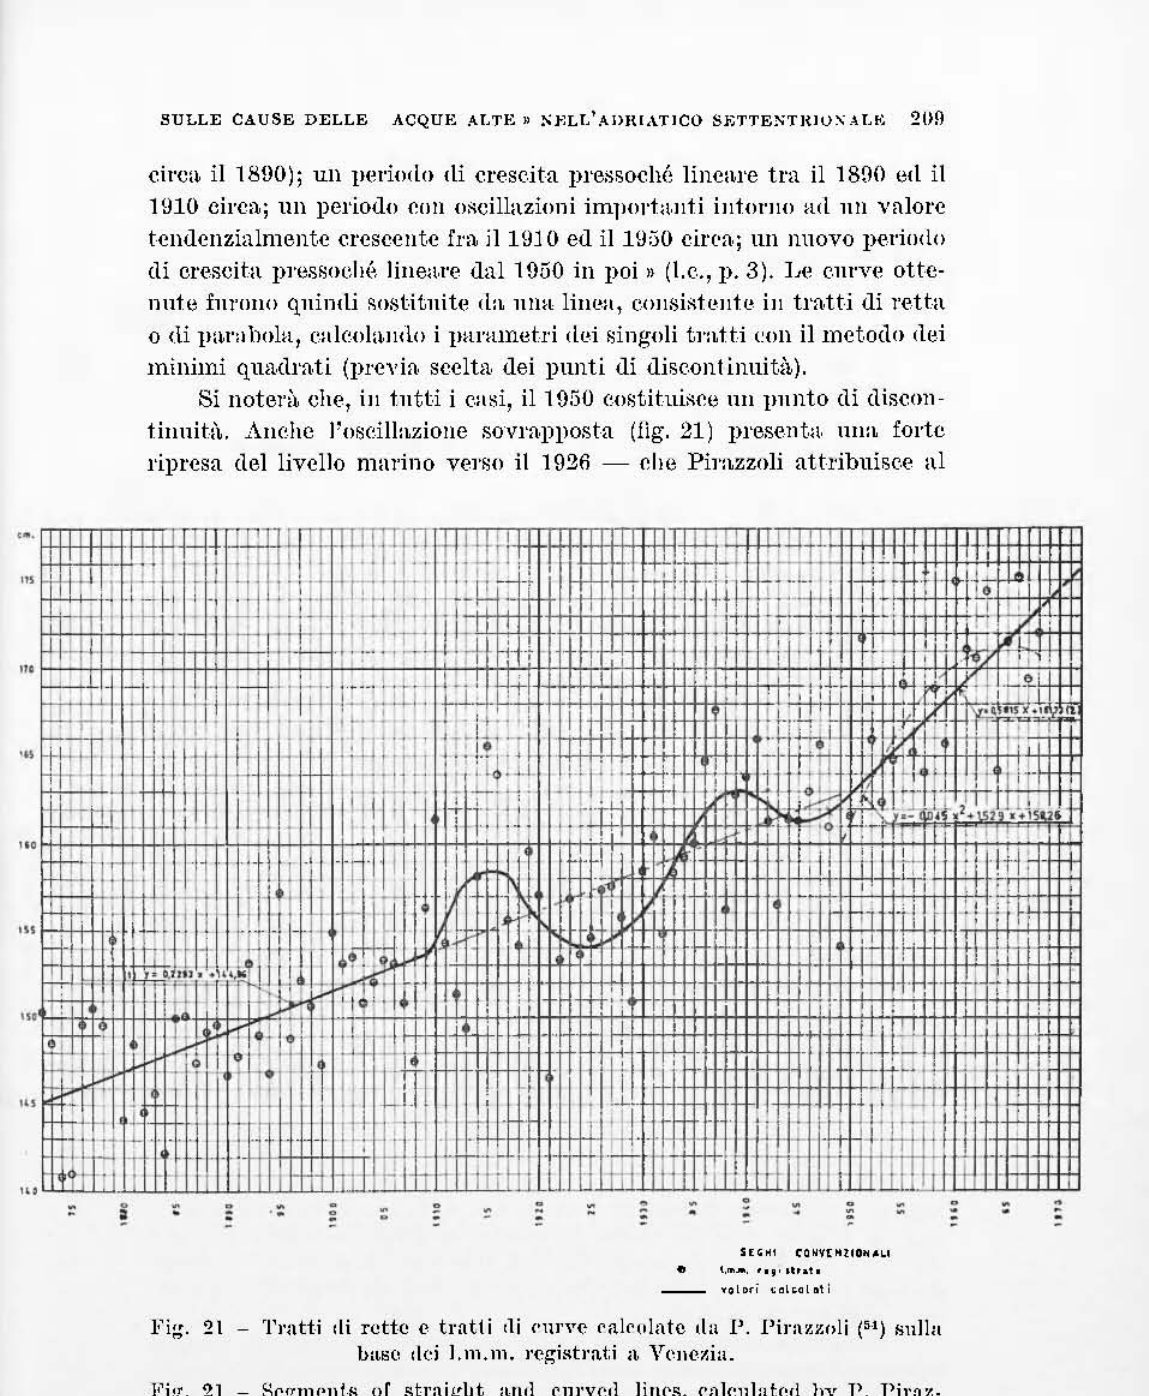
Fig. 21 - Segments or strai,dJt :uul rllrve,l !inps, enkulatcrl hy l'.